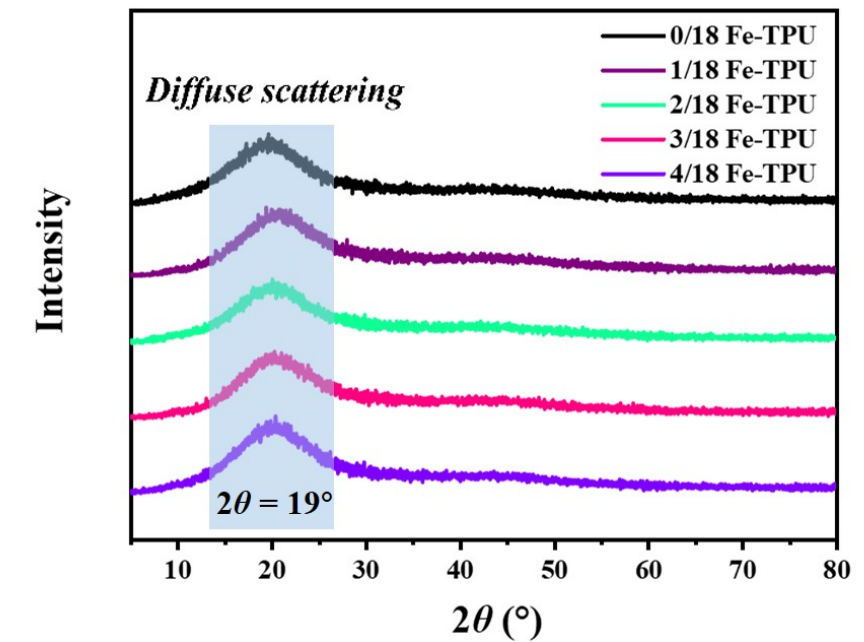
Figure 8. XRD spectra of TPU reinforced with FeCl 3 .